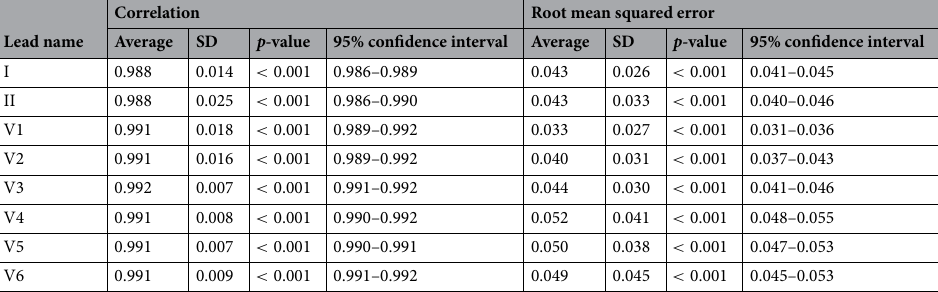
Table 2. Correlation and root mean squared error (RMSE) statistics of the digitised results from 515 standard 3 by 4 ECG images and the ground truth digital ECGs (validation